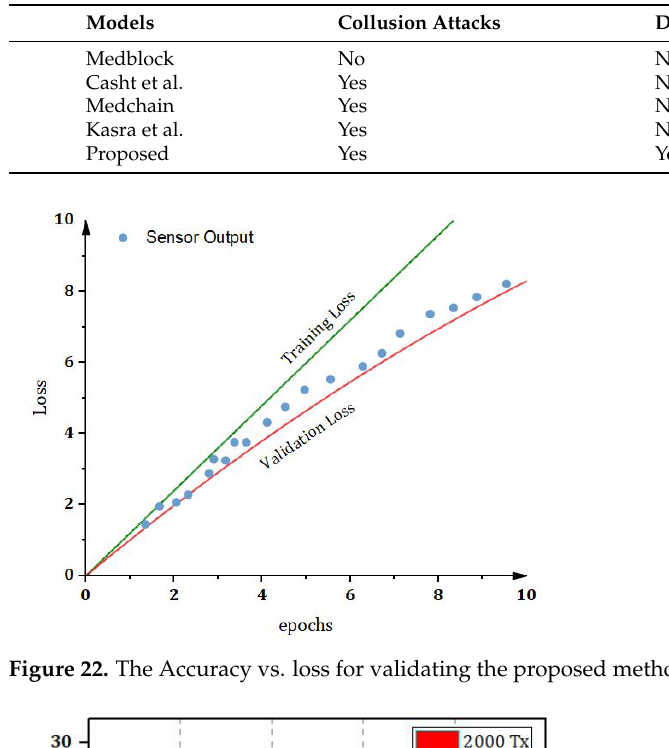
Figure 21. Comparative Analysis of keyword Search Mechanism in proposed and Benchmark Model. Table 4. Attack Resistance based on Secure search Mechanism.